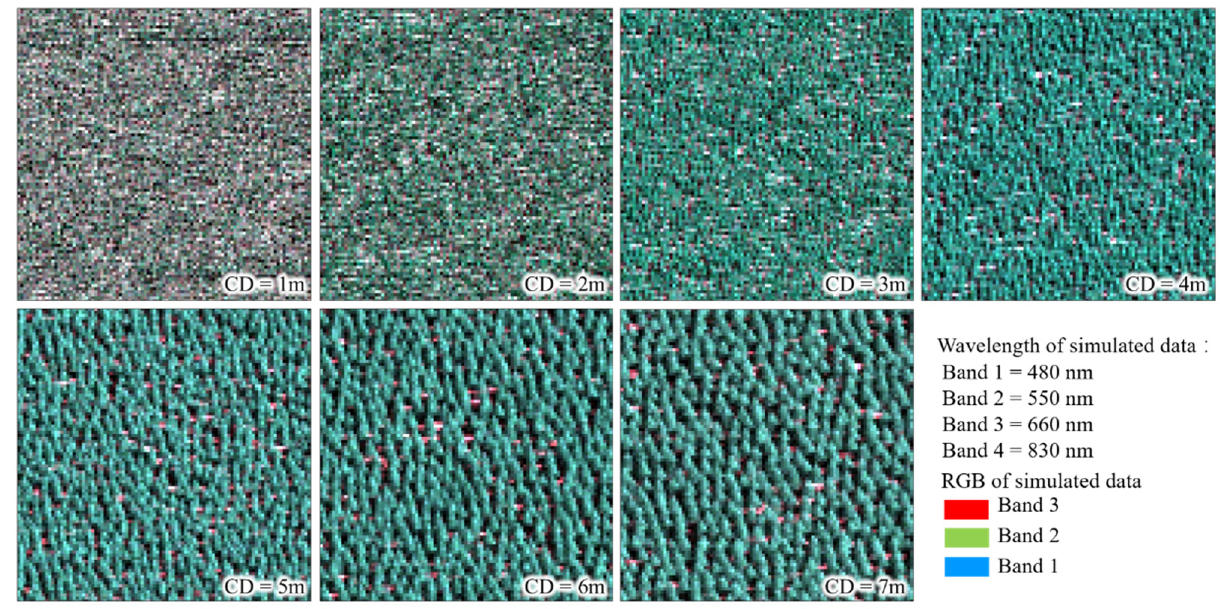
Figure 4. Simulated multispectral images with various sizes of CDs based on the LESS model.